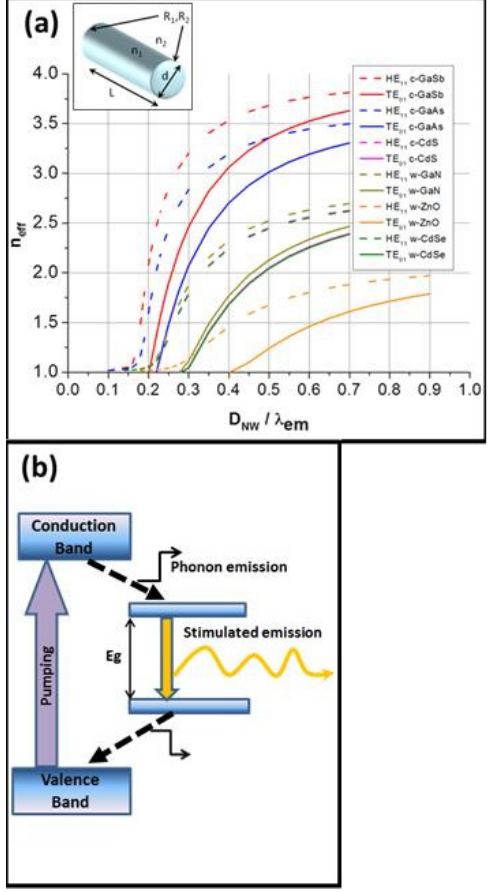
Figure 2: (a) Effective index of the HE 11 (dashed) and TE 01 (solid) propagating modes versus diameter in infinite cylindrical nanowires for different semiconducting materials, with respect to their emis- sion wavelength. The prefix “c” stands for cubic zincblende, and “w” for hexagonal wurtzite crystal phases (inset: schematic of a nanowire with relevant parameters: length L, diameter d, internal index n 1 , medium index n 2 , and end facet reflectivities R 1 and R 2